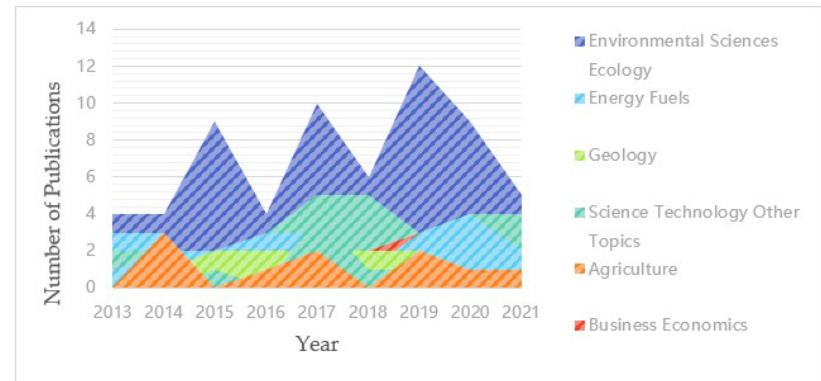
Figure 3. Research